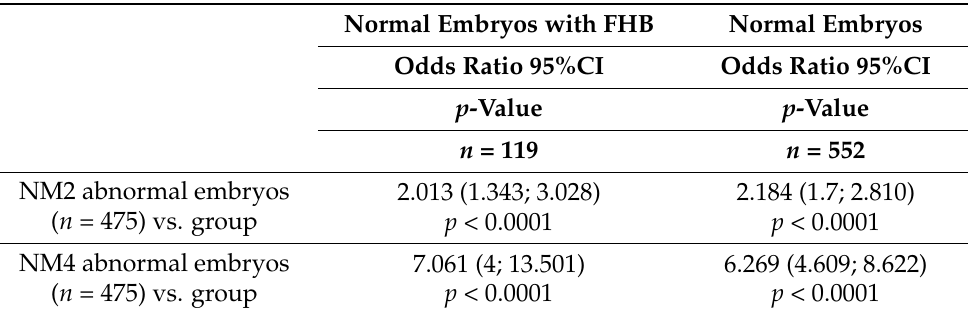
Table 3. Occurrence of multinucleations in 2-cell stage and 4-cell stage embryos and groups normal embryos (euploid) with proven clinical pregnancy, normal embryos (euploid) and abnormal embryos (aneuploid).